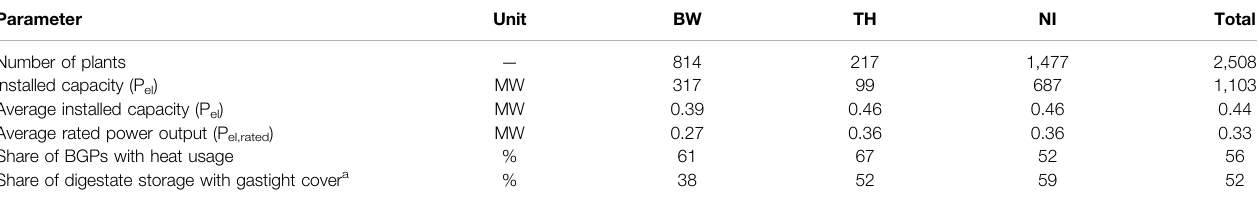
TABLE 2 | Main model input data derived from the transmission system operators data for the year 2018. Parameter